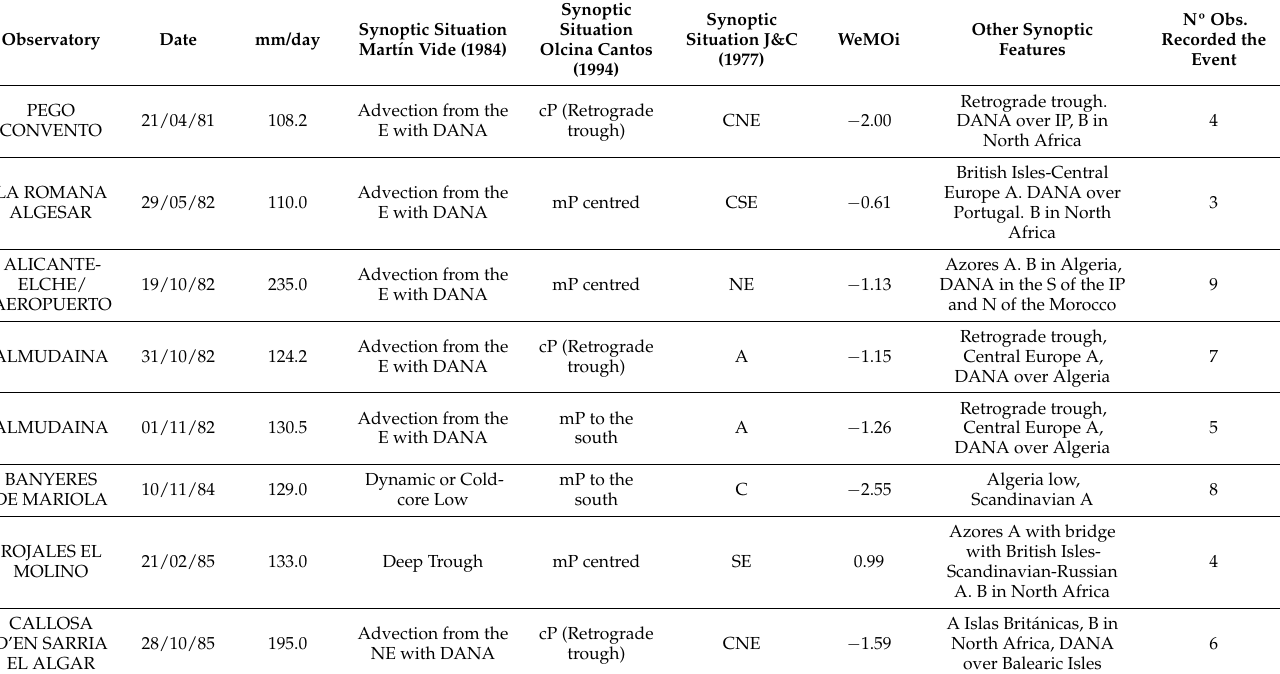
Table A1. Study events—Dates on which precipitation equal to or greater than 100 mm/day occurred at any observatory in Alicante, synoptic situation, classification methods, WeMOi value (1981–2020), other synoptic characteristics and numbers of observatories where the event is